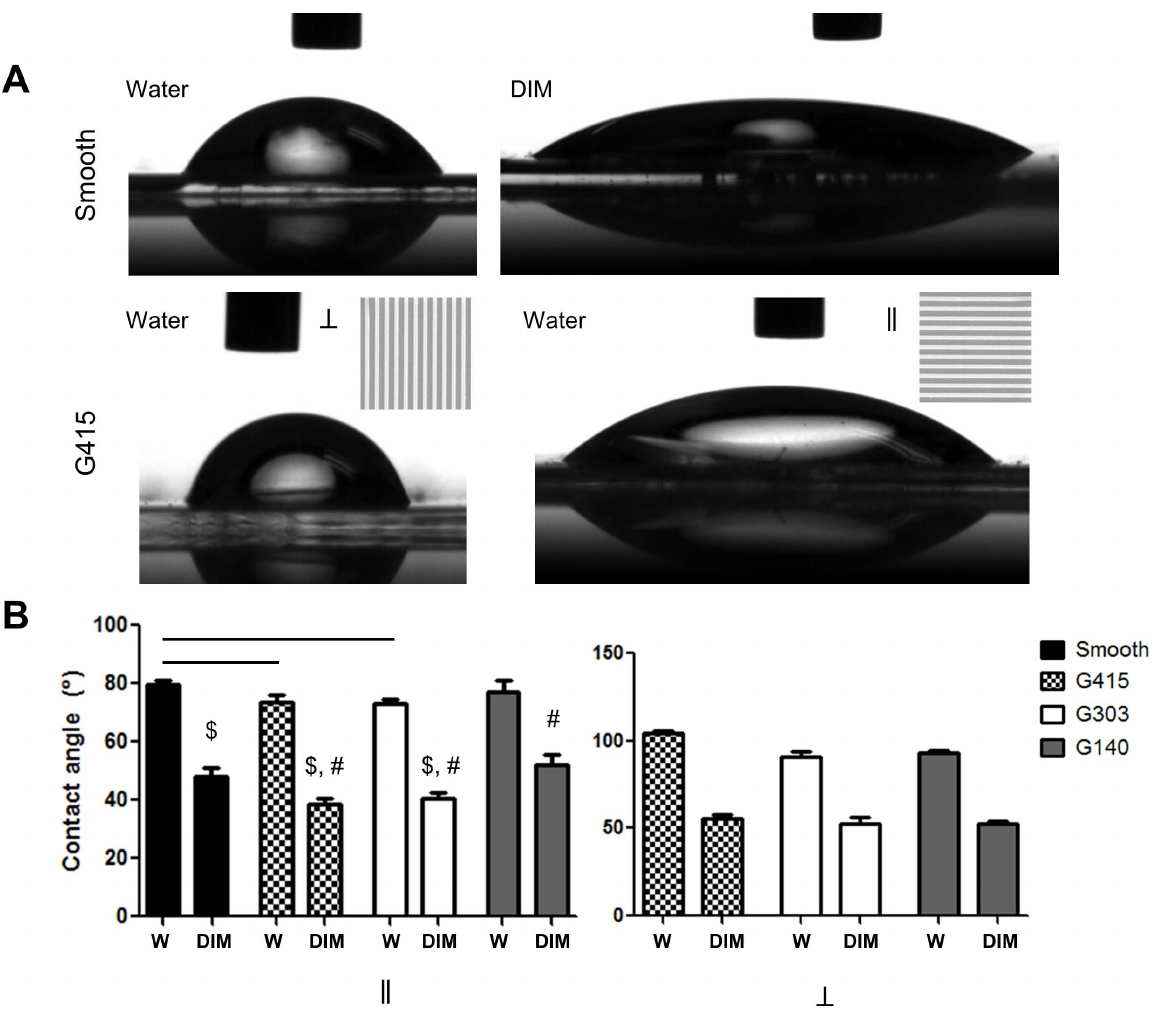
Figure 3. Contact angle measurements show anisotropy dependent on surface orientation. (A) Images illustrating wettability of water or diiodomethane on smooth or G415 PMMA films. Insets on G415 images show the direction of the underlying topography ( H indicates a drop perpendicular to the long axis of the topography; I indicates a drop parallel to the long axis of the topography). Contact angle anisotropy can be observed on the G415 surfaces and also occurred on other nanoPMMA films (data not shown). (B) Graphs illustrate the quantification of the contact angles both parallel and perpendicular to the grating direction. Significant differences were seen between smooth PMMA and G415 and G303 (parallel) for water and DIM ( $ ) contact angles ( $ ). All surfaces, when perpendicular contact angles for nanoPMMA were compared to smooth PMMA for both liquids, were significant. W indicates contact angle measurement of water; DIM indicates indicates contact angle measurement of diiodomethane. All significance was p , 0.05 (or smaller), n $ 3. doi:10.1371/journal.pone.0090719.g003 cell proliferation after two weeks but does not significantly impact proliferation at earlier time points (day 4 and 7).